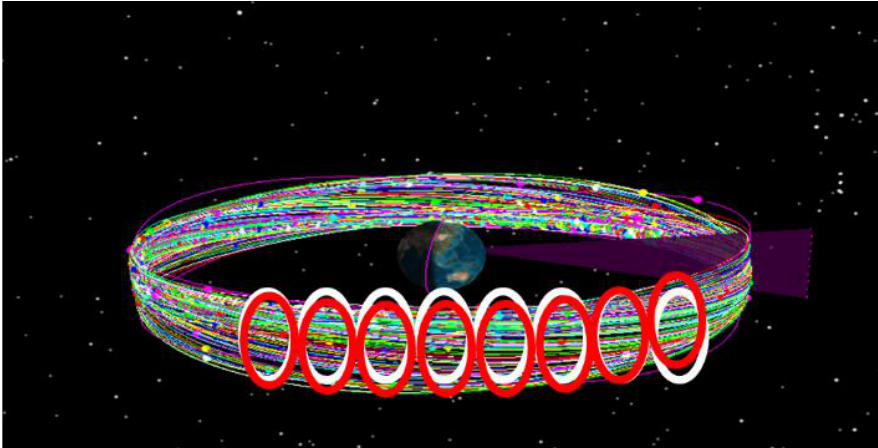
Figure 4. The pointing area of the satellite ’ s sensor. (The white area in the figure represents the observation area before the improved observation mode is used, and the red area in the figure rep- resents the observation area after the improved observation mode is used.)